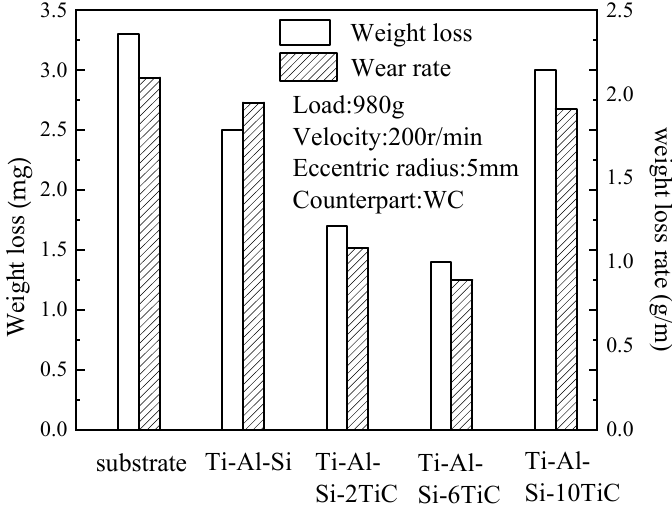
Figure 10. Mass loss and wear rate of substrate and the laser cladding coatings. The worn morphologies with different content of TiC powder are shown in Figure